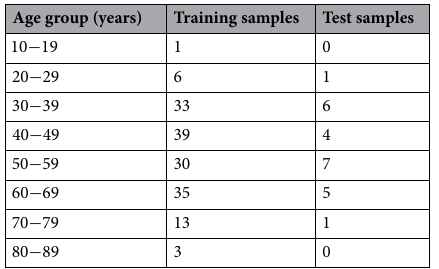
Table 1. Age distributions of training and test samples.